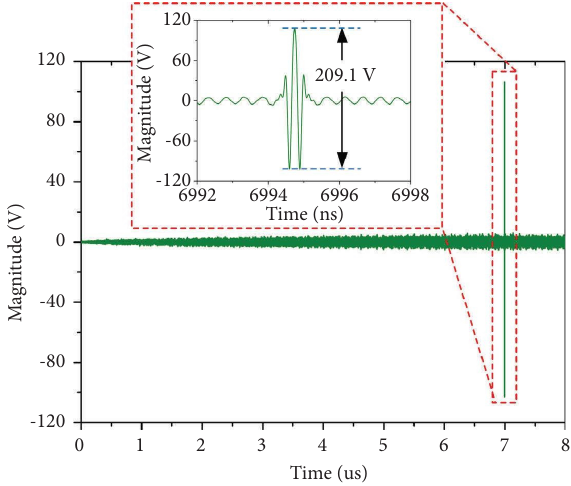
Figure 4: Te obtained simulated USP signal by using the im- proved simulation model shown in Figure 3 with PEC